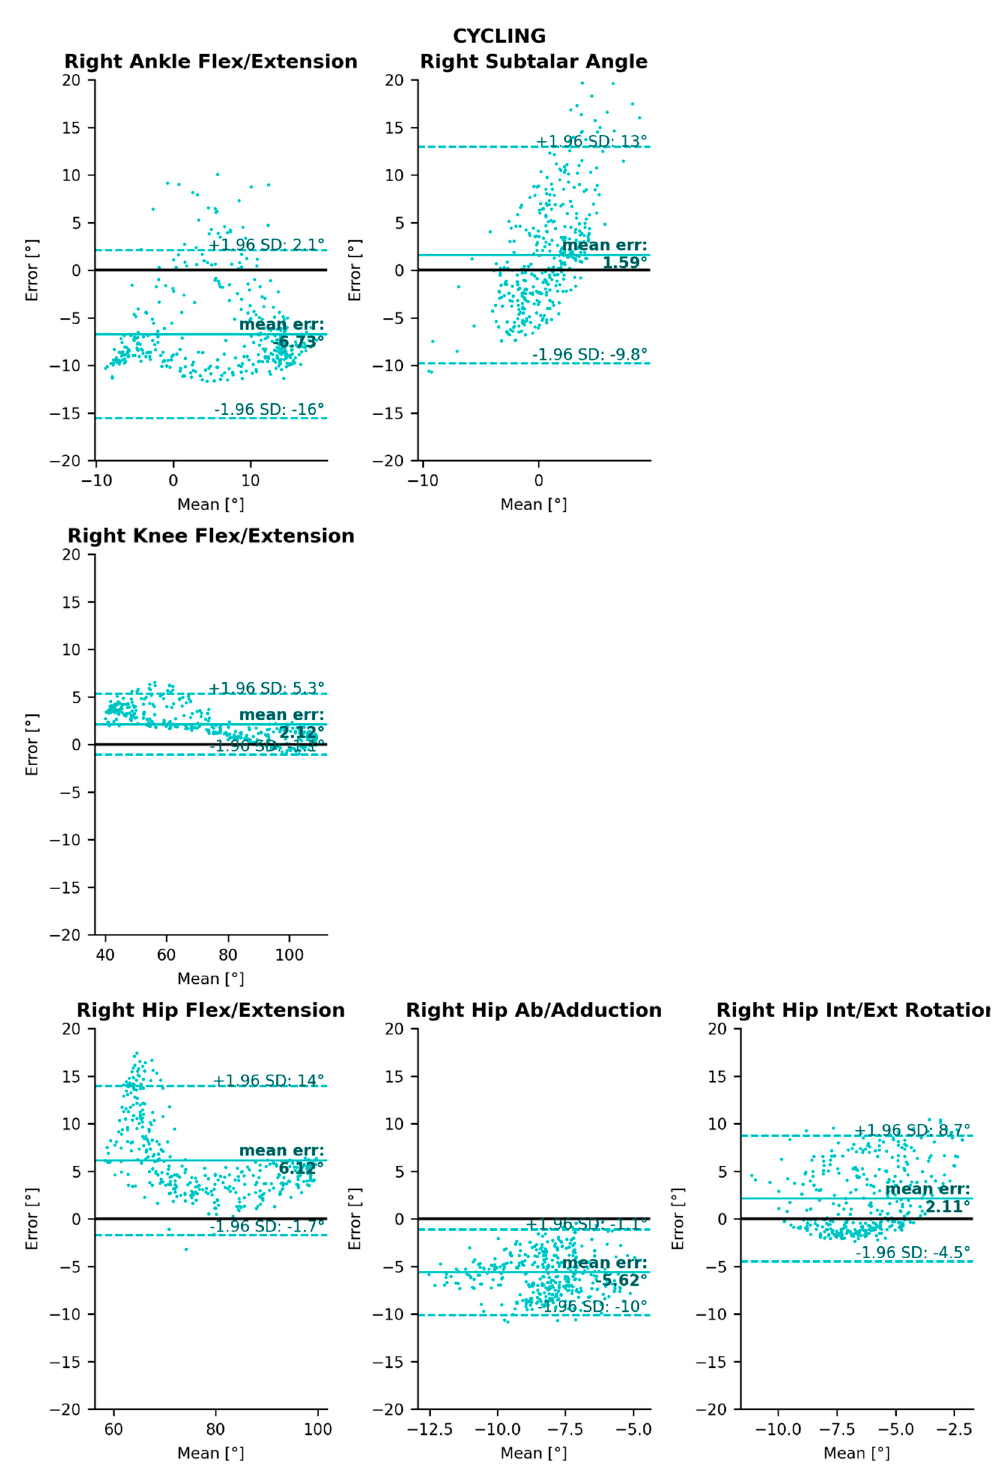
Figure A8. Bland–Altman analysis of lower-body joint angle errors for the cycling task. Mean bias is represented as a horizontal solid, bold line, and 95% limits of agreement are represented as dotted lines.